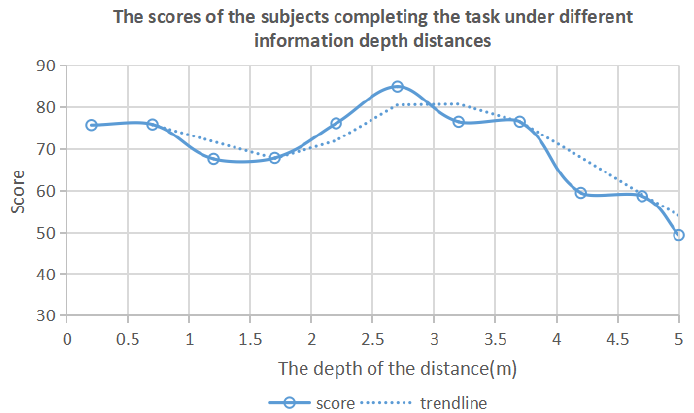
Figure 4. The trend graph of the scores of the subjects completing the task at different depth dis- tances.